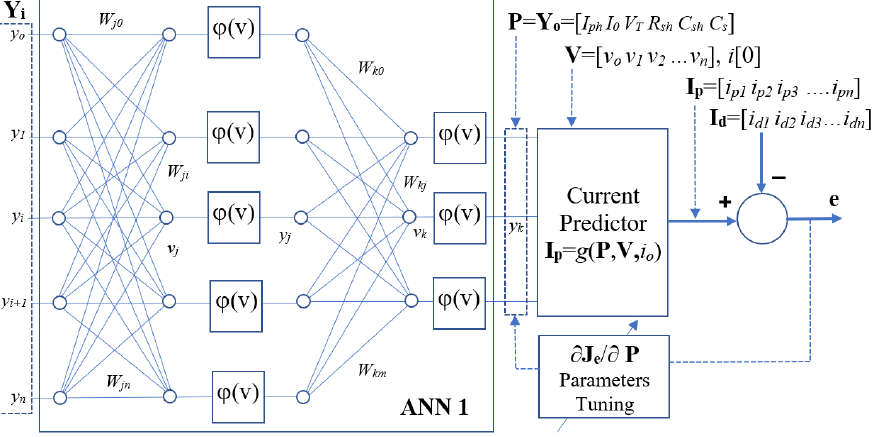
Figure 6. Block Diagrams of the Multi-layer ANN1 parameters estimator.